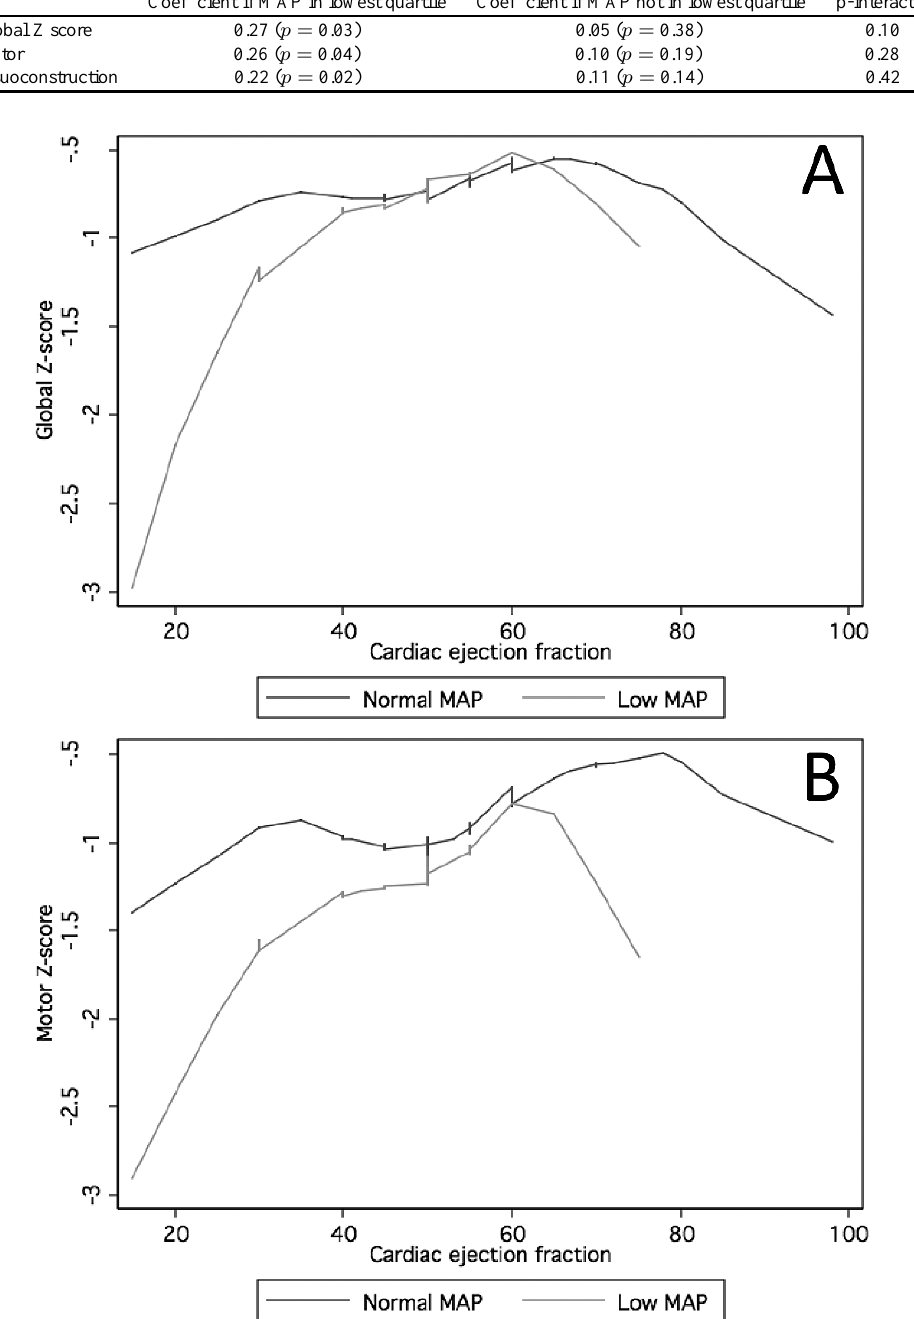
Fig. 3. Lowess curves for individuals with normal mean arterial pressure (MAP) (top 3quartiles) versus low MAP(lowest quartile), demonstrating association between global (panel A) and motor (panel B) Z-scores and cardiac ejection